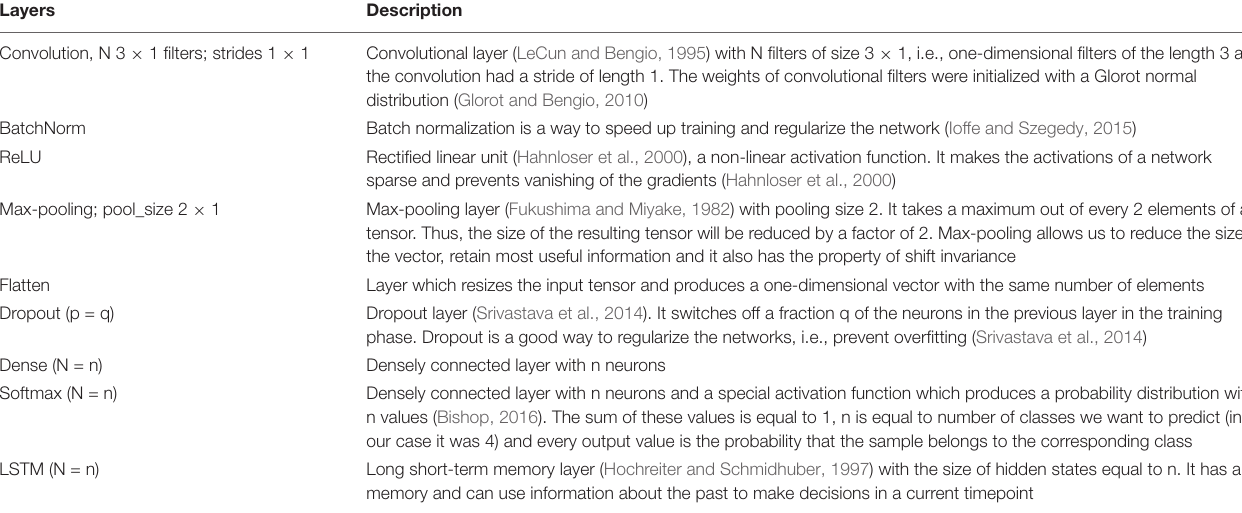
TABLE 2 | Description of the different layers and notions used in the architecture of the networks ( Figure 2 ).